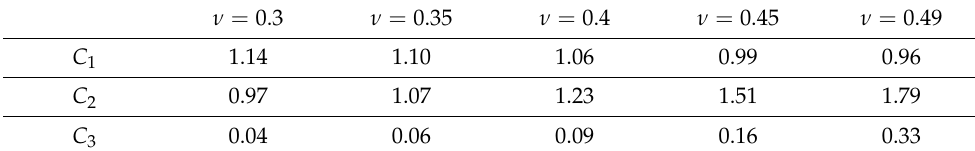
Table 3. Dimensionless bedding stiffness constants 𝐶 (cid:4668)(cid:2869)(cid:2879)(cid:2871)(cid:4669) for different Poisson’s ratios. 0.3 ν=